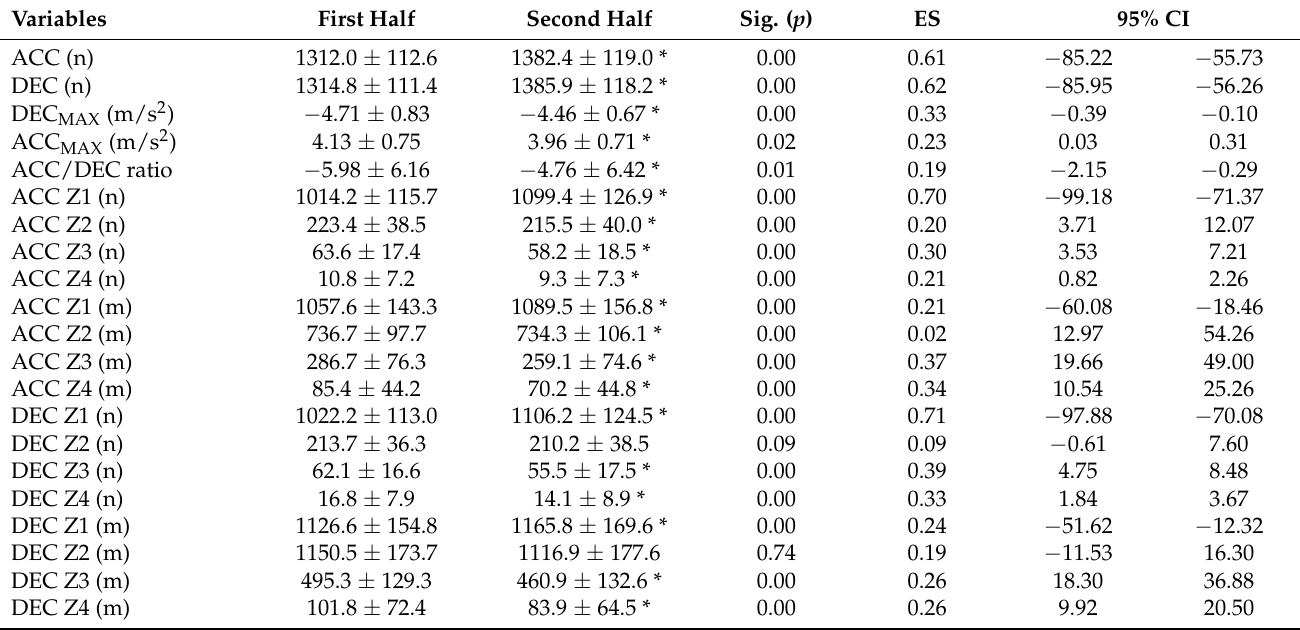
Table 2. Relationship between acceleration and deceleration demands of female field referees in match play.